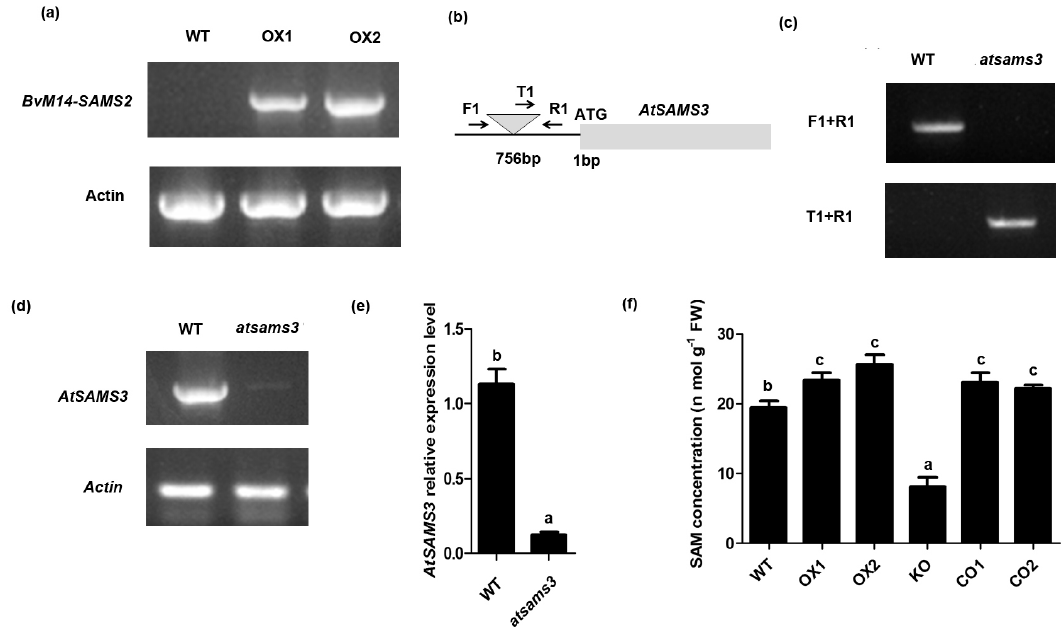
Figure 3. Identification of atsams3 mutant and overexpressed BvM14-SAMS2 in Arabidopsis plants. ( a ) quantitative reverse transcription-polymerase chain reaction (RT-PCR) analysis of the expression levels of overexpressed BvM14-SAMS2 (OX1 and OX2) in Arabidopsis plants; ( b ) Structure of the AtSAMS3 gene. The T-DNA insertional site was 756 bp upstream of the start codon, as indicated by a triangle. The primers used to identify the T-DNA insertion were marked with arrows; ( c ) PCR analysis of the T-DNA insertion in the atsams3 mutant (KO); ( d ) RT-PCR analysis of the expression levels of AtSAMS3 in atsams3 mutant and wild type (WT); ( e ) Real-time PCR analysis of the expression levels of AtSAMS3 in the atsams3 mutant; ( f ) The concentration of S -adenosylmethionine (SAM) in 20-day old whole seedlings of wild type (WT), overexpressed BvM14-SAMS2 (OX1 and OX2), AtSAMS3 konckdown mutant (KO) and BvM14-SAMS2 in mutant complementation seedlings (CO). Data are the means of three biological replicates (SD) and each replicate contains five seedlings. Different letters indicate significant difference at p < 0.05.